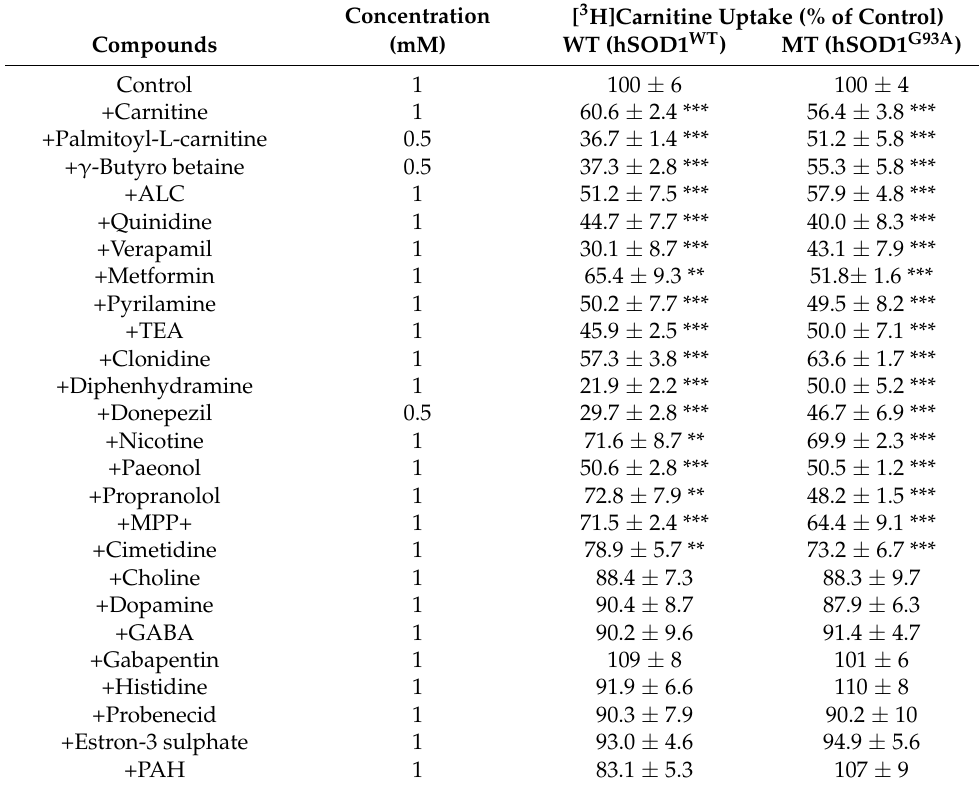
Table 2. Effect of transporter inhibitors and substrates on [ 3 H]L-carnitine uptake by NSC-34 cell